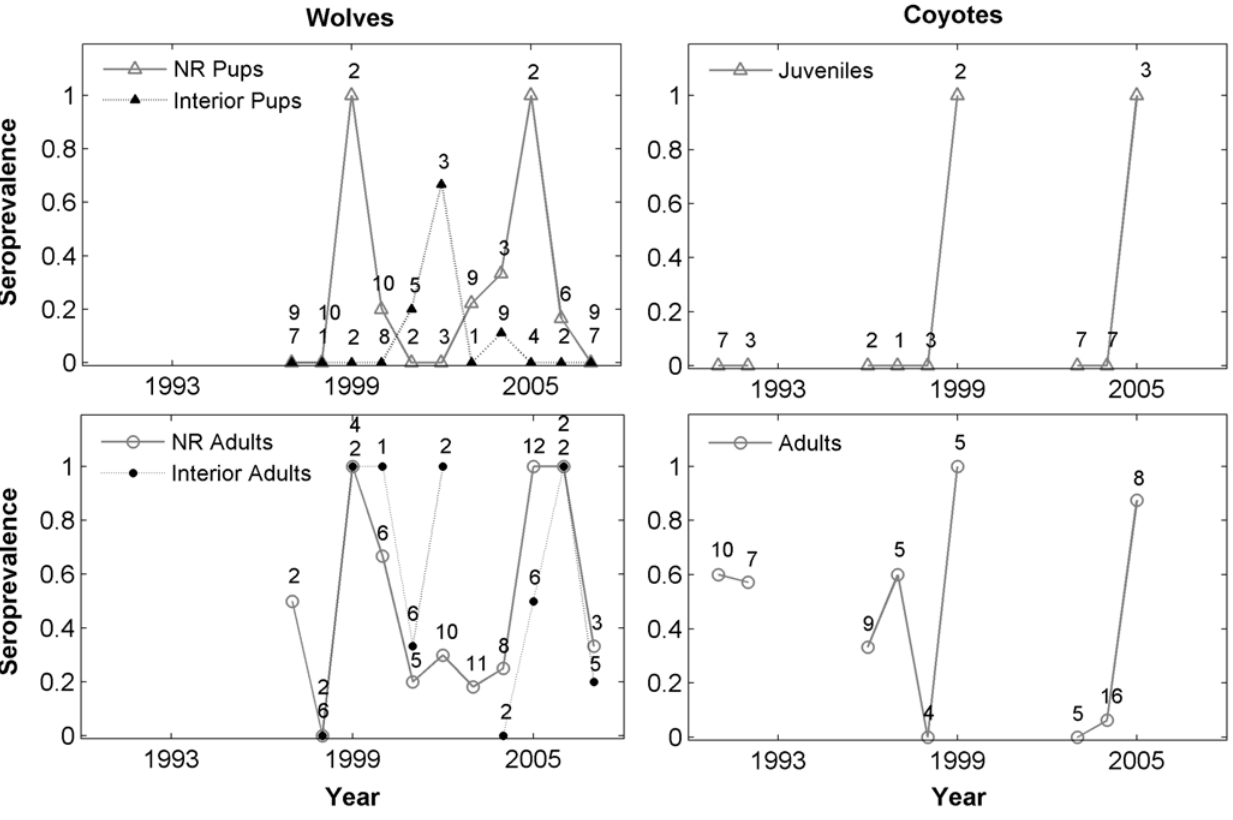
Figure 1. Annual canine distemper virus seroprevalence among wolves and coyotes in Yellowstone National Park, 1991–2007. Among wolves, data are divided by location (Northern Range [NR] and Interior), whereas coyotes were sampled only on the NR. Sample sizes are displayed above seroprevalences (see Table S3 for number of packs sampled and 95% CIs). Where points overlap, the top number refers to NR, the bottom to Interior.